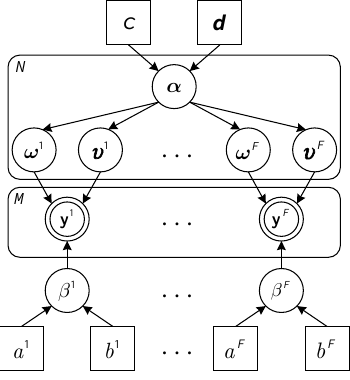
Figure 4. Graphical model for the joint sparse